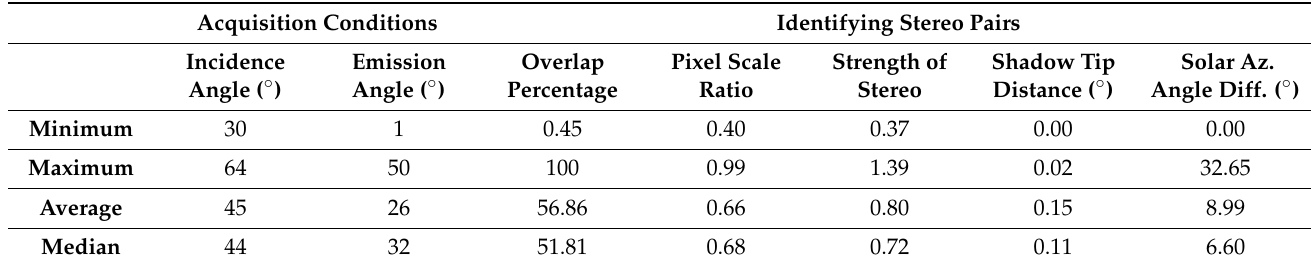
Table 1. Image selection criteria statistics for the stereo images used in this